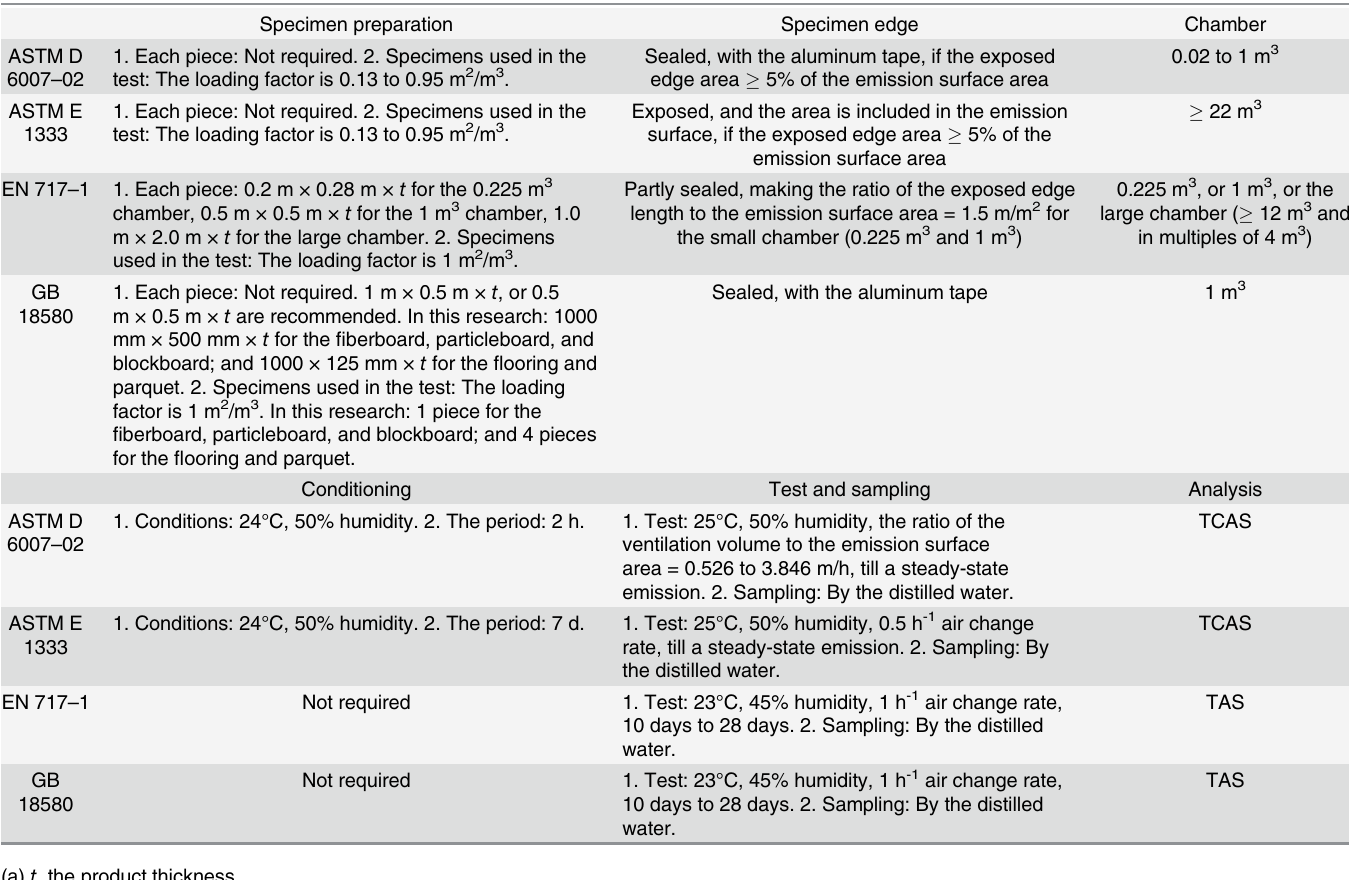
Table 4. Characterization of the Product Formaldehyde Emission: The Environmental Chamber Methods in Popular Standards and Chinese GB